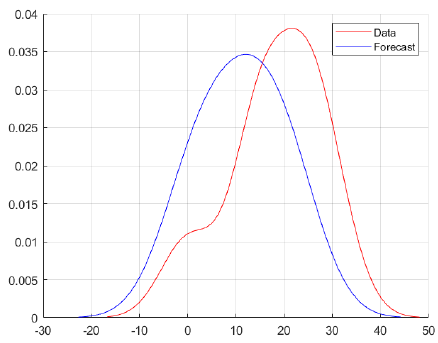
Figure 13. Estimated density functions of forecasted and original data.